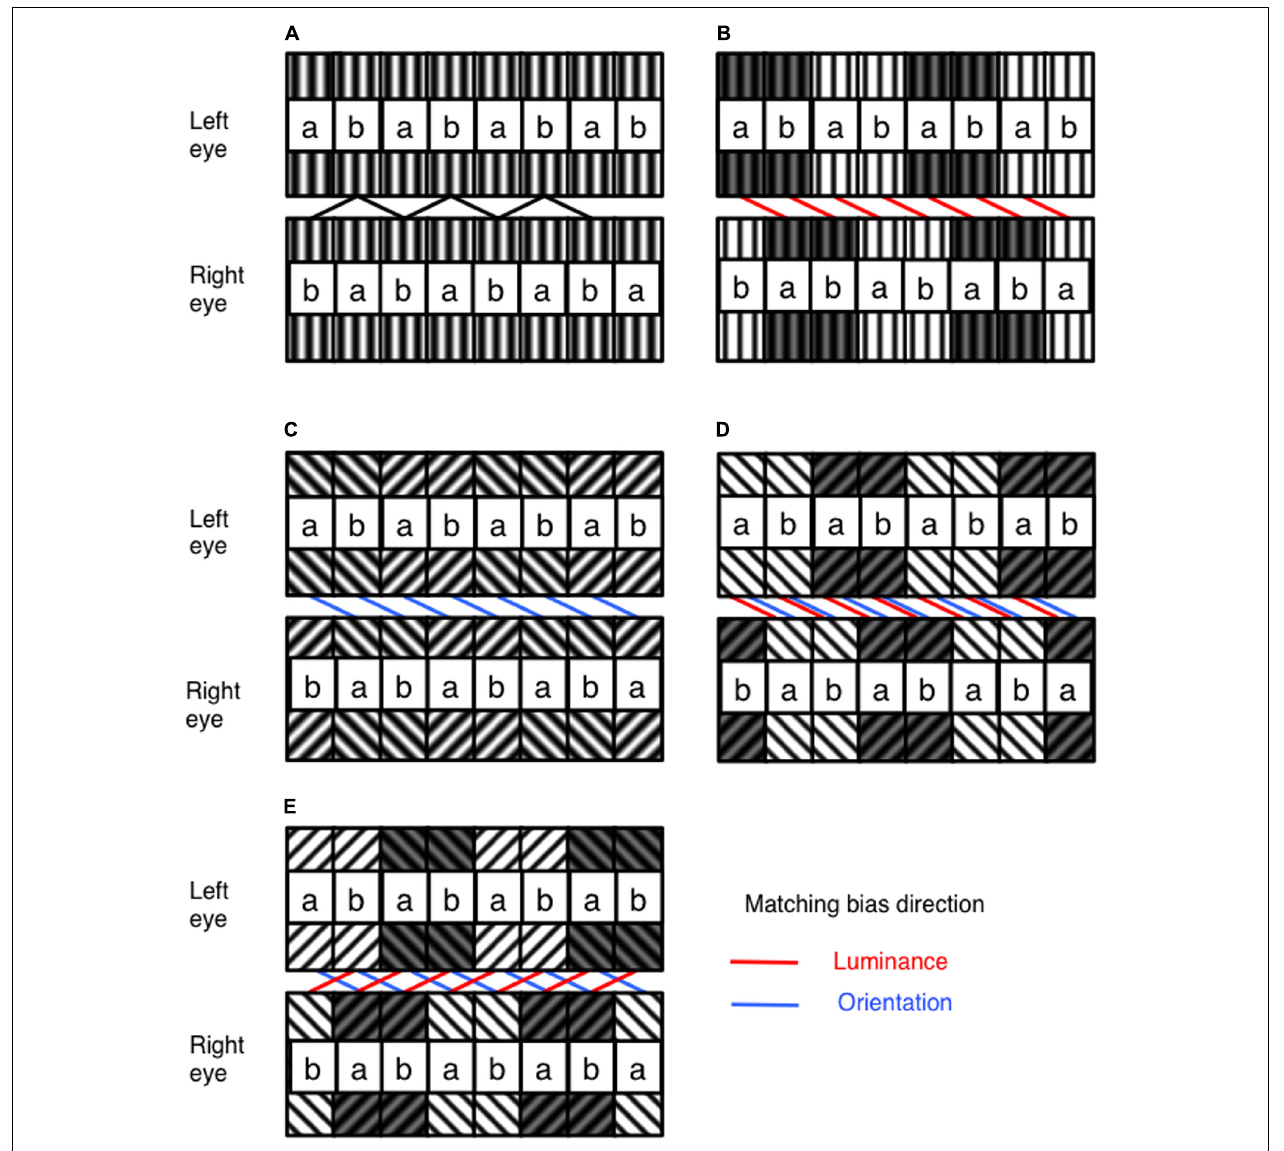
corresponding ab pairings can also be used to bias disparity matching. Luminance and orientation similarity can be introduced so as to bias in (D) the same or (E) competing directions. The direction of matching based on similarity in luminance and orientation are indicated by the red and blue lines on the figures, respectively. Spatial frequencies for the experimental stimuli were identical across all orientation and luminance similarities, and are shown in this figure for illustrative purposes only. The labeling of ab pairings indicated in this figure were not present in actual experimental